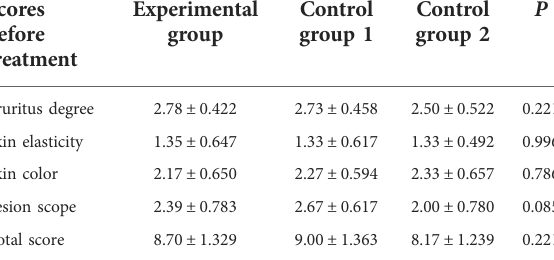
TABLE 2 Comparison of three groups before treatment.